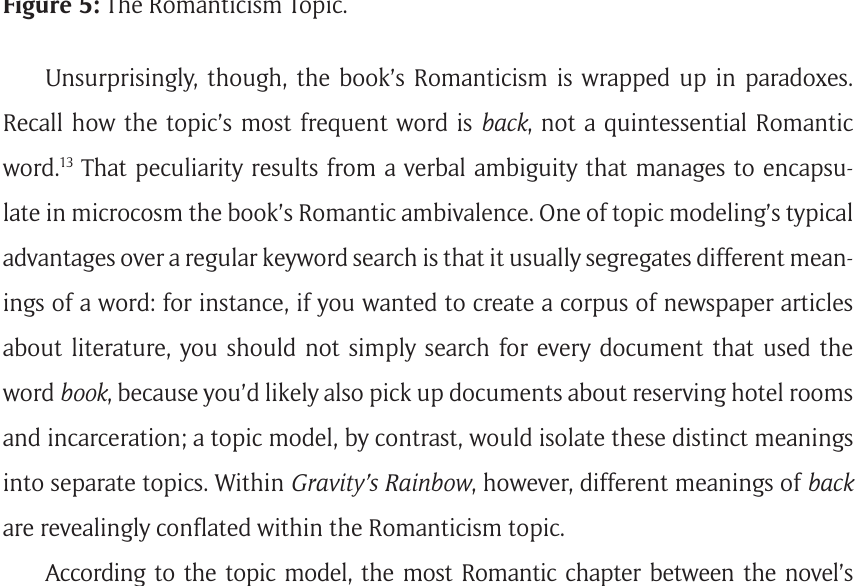
Figure 5: The Romanticism